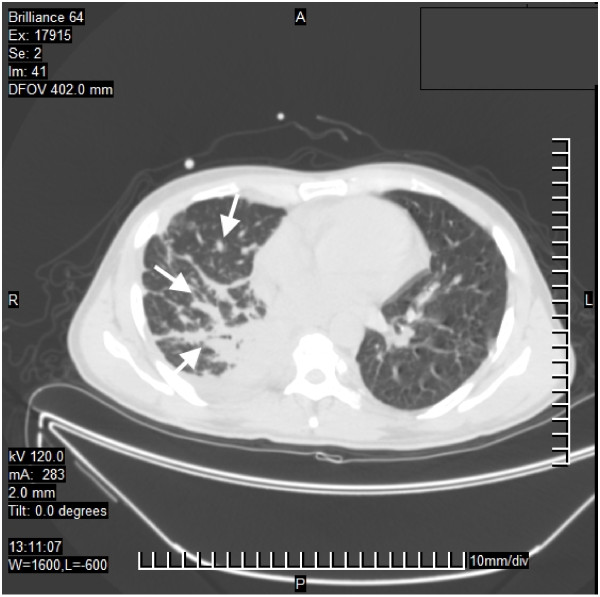
Computed tomography image of lung infection by Mycobacterium abscessus subsp. bolletii. The white arrows show parenchymal consolidation in both lungs, predominantly in the right side, and patchy ground-glass appearance with nodules.